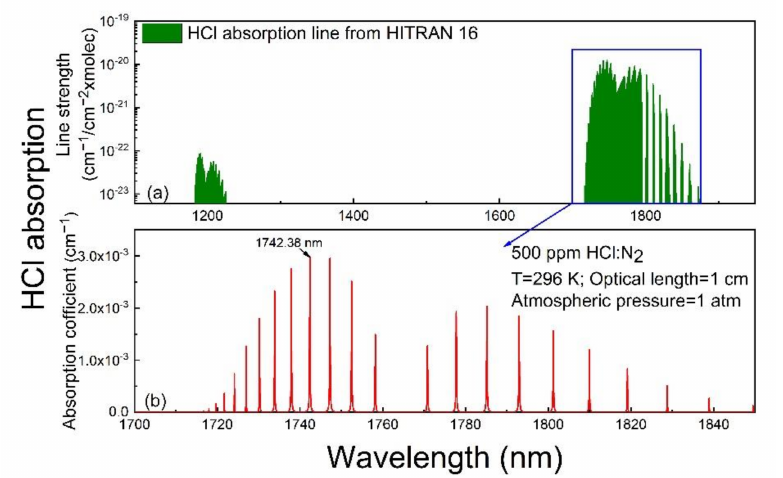
Figure 1. Simulation of HCl absorption based on the HITRAN 2016 database. ( a ) Absorption line strength; ( b ) absorption coefficient, at 296 K, standard atmospheric pressure, and an optical path length of 1 cm for 500 ppm HCl:N 2